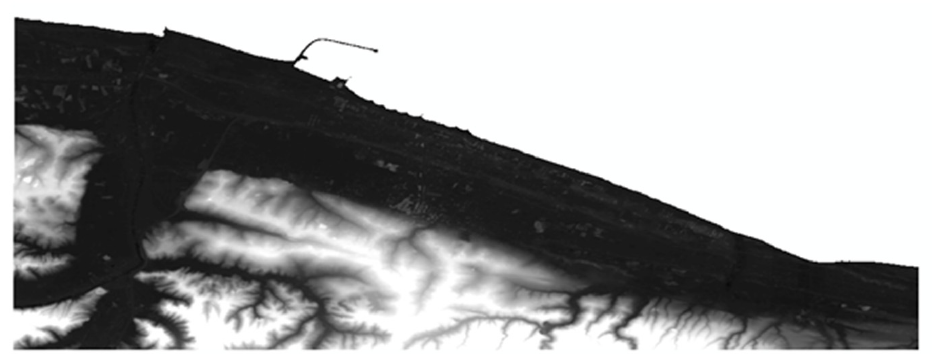
Figure 2. DEM of the Karasu region,